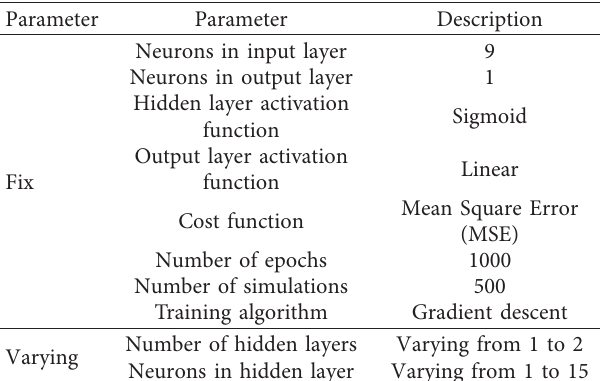
Figure 3: Methodology flowchart of the present study. Table 2: Summary of different ANN characteristics and investi- gation parameters in this